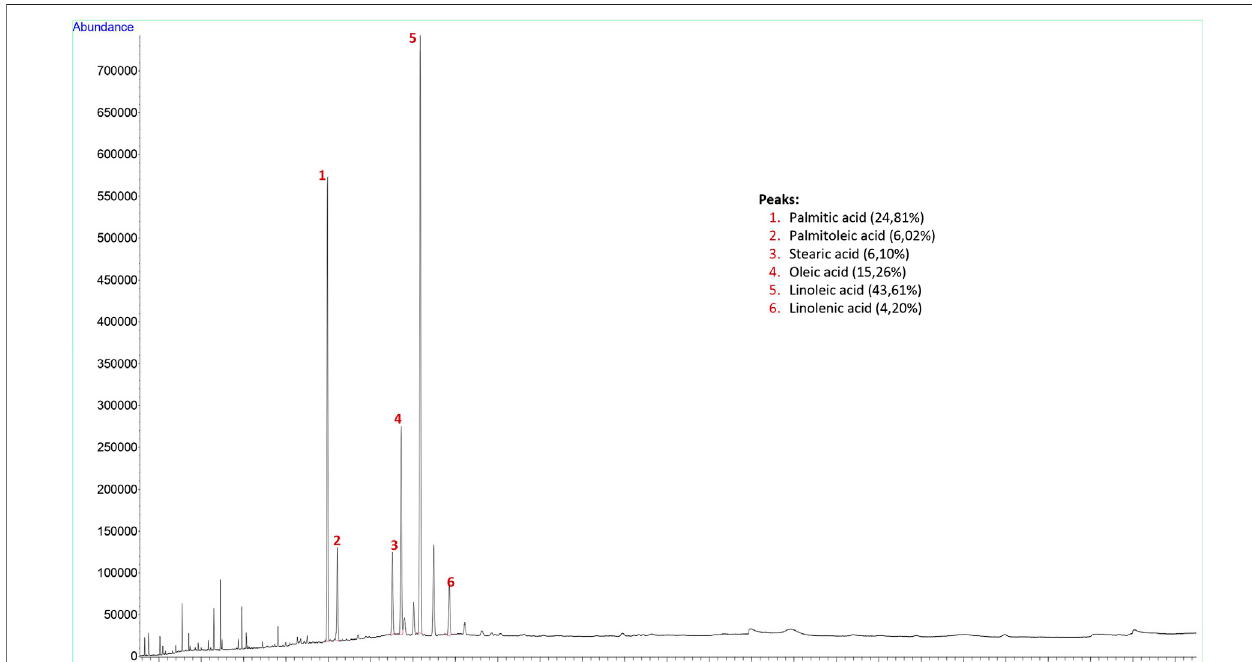
FIGURE 1 | GC-FID chromatogram of hexane extract of grape ( Vitis vinifera ) seed.